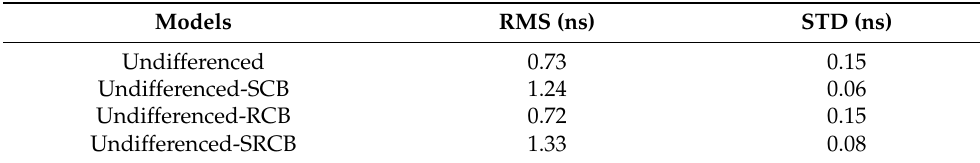
Figure 8. RMS and STD values of clock estimates compared with the IGS final products on DOY 031. The mean values are also plotted near the right edge of each panel. G01 is the reference satellite. Table 3. The mean RMS and STD of clock estimates by different models when compared to the IGS final products on DOY 031.